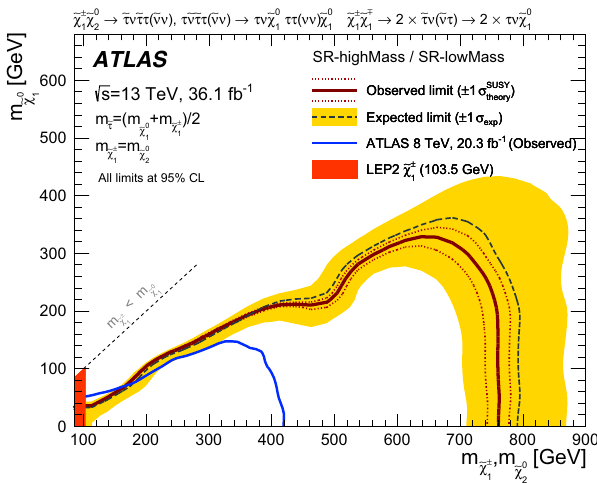
Fig. 7 The 95% CL exclusion contours for simplified models with ˜ χ + ˜ χ − 1 1 production (left) and production of The text provides details of exclusion curves and uncertainty bands.